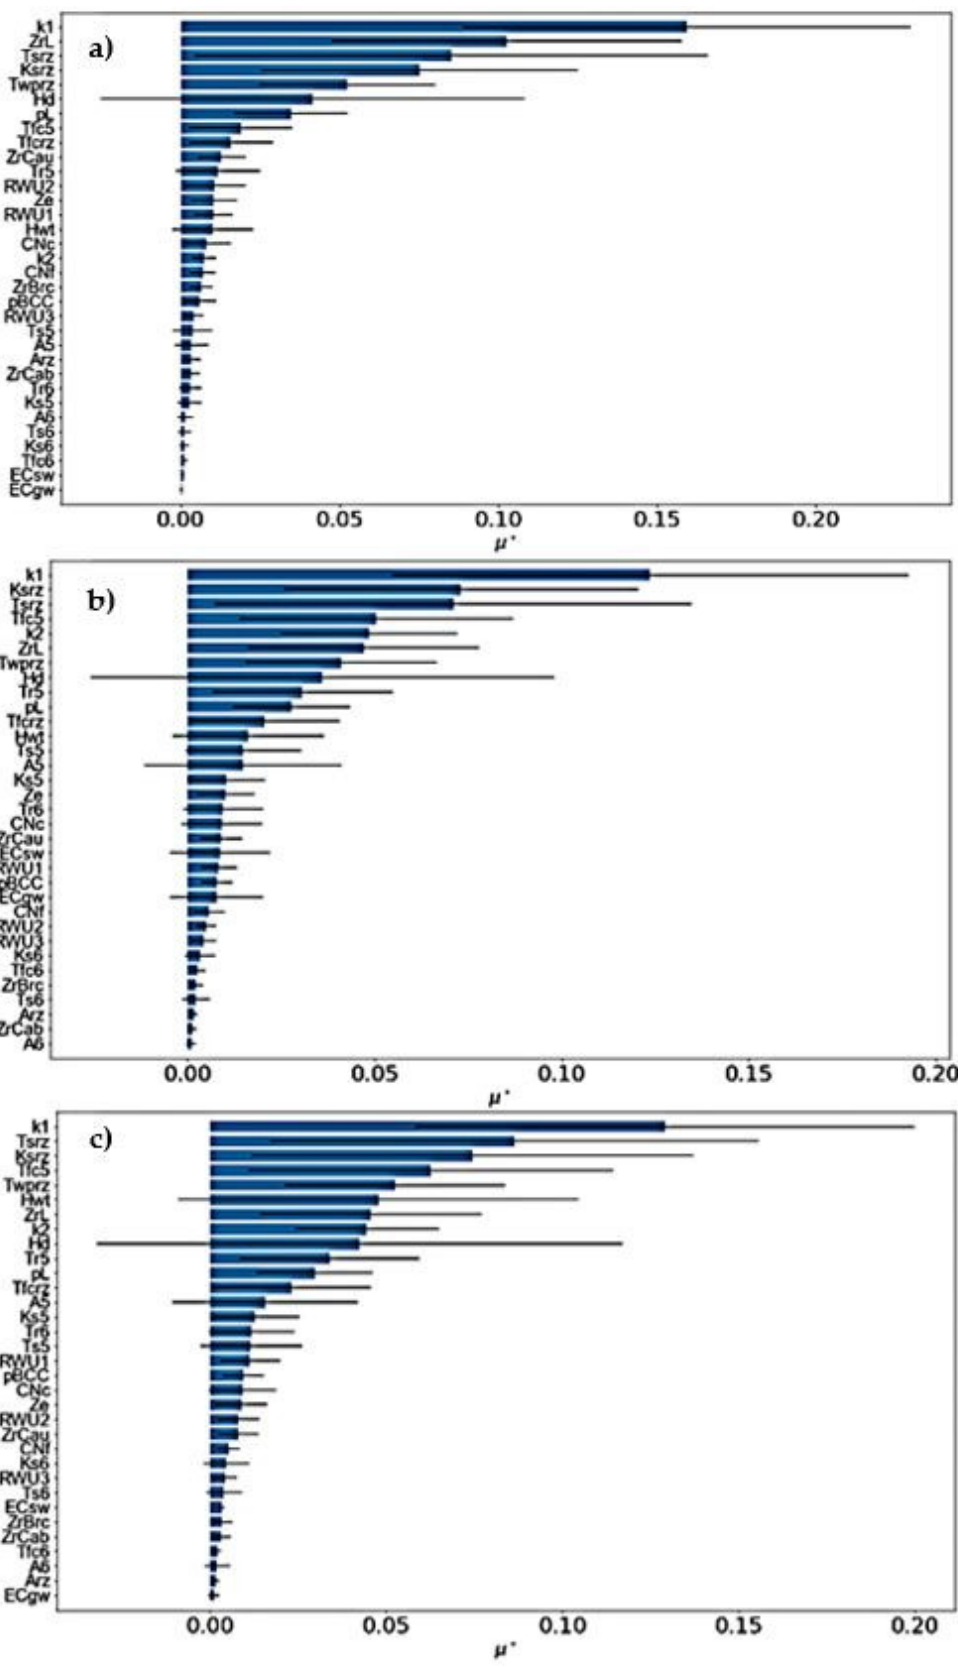
Figure 5. Morris method µ * (the absolute of the mean elementary effect) values for soil depth layers. ( a ) 0.03–0.30 m; ( b ) 0.3–61 m; ( c ) 0.61–0.91 m depths.